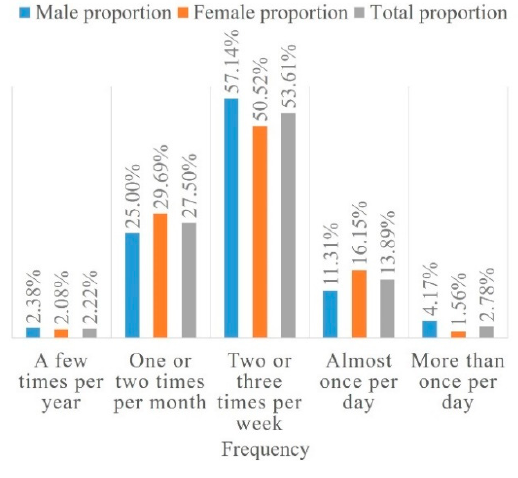
Figure 8. Frequency preference.